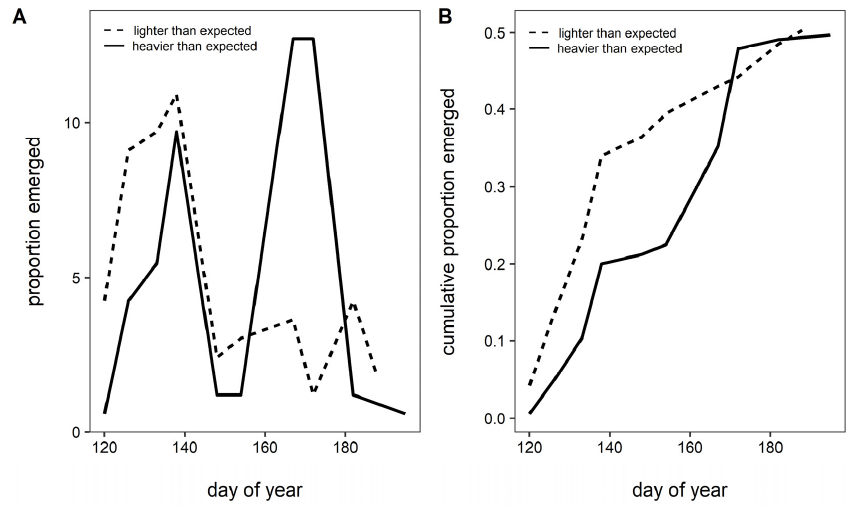
Figure 4. Queen body condition was strongly associated with the two queen emergence peaks. ( A ) Relatively light queens (dashed lines) dominated the first emergence peak, and ( B ) tended to emerge rapidly early in the season. Conversely, relatively heavy queens (solid line) emerged during both peaks, but dominated the second emergence peak, when lighter than expected queens were scarce (A; χ 21 = 17.87, p < 0.0001, n = 165).